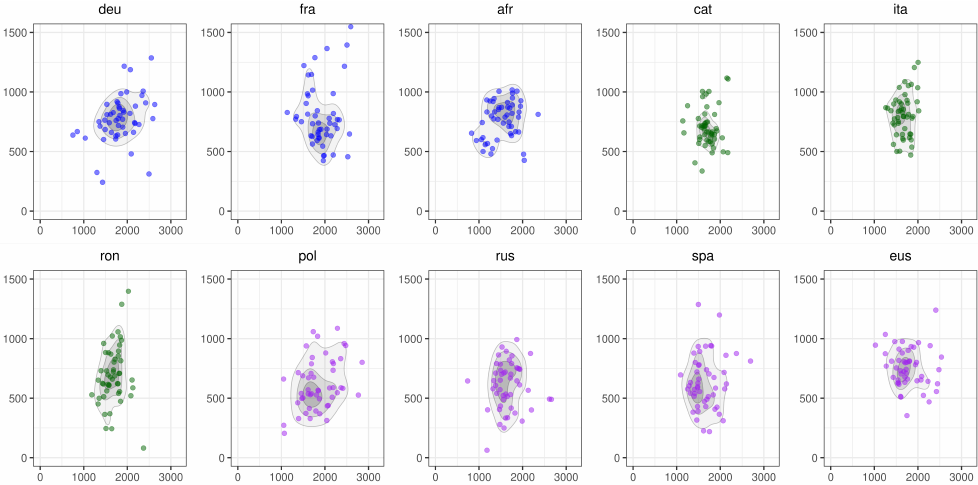
Figure 3. The distribution of formants for the vowel [a] across the 10 languages of the data set. The x-axis represents F2 and the y-axis indicates F1. The labels on the top of each sub-figure refer to the iso code of the 10 languages in the data set. The colors indicate the group to which the language is affiliated with in terms of number of timbres: blue = large, green = medium, purple =